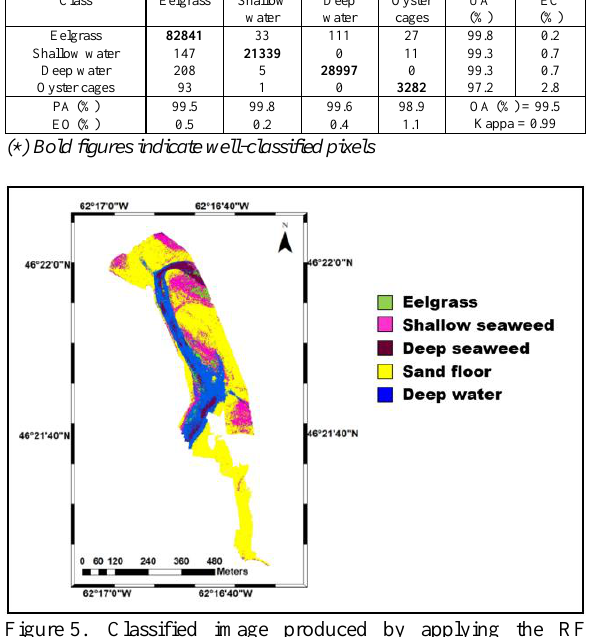
Figure 5. Classified image produced by applying the RF classifier to the reflectance band images, associated vegetation indices and bathymetric ratios to the UAV image of